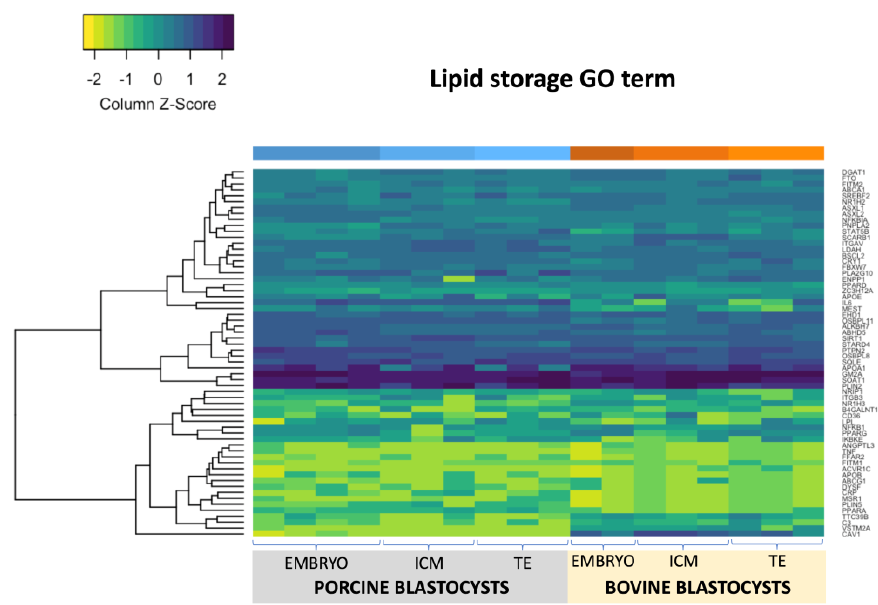
Figure 4. Heatmap of gene ontology (GO) term “lipid storage” representing porcine and bovine parthenogenetic, blastocyst stage embryos, ICM and TE cell lines.